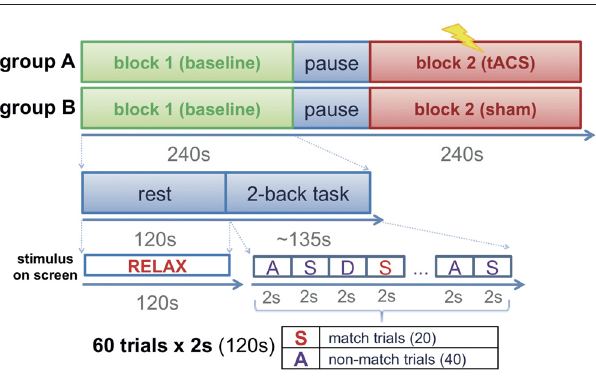
FIGURE 1 | Experimental design . Participants were assigned to one of two groups (group A: transcranial alternating current stimulation (tACS); group B: sham stimulation). The experimental session consisted of two blocks (block 1: baseline block; block 2: interventional block). While group A received tACS during block 2, group B performed the task in absence of stimulation (sham